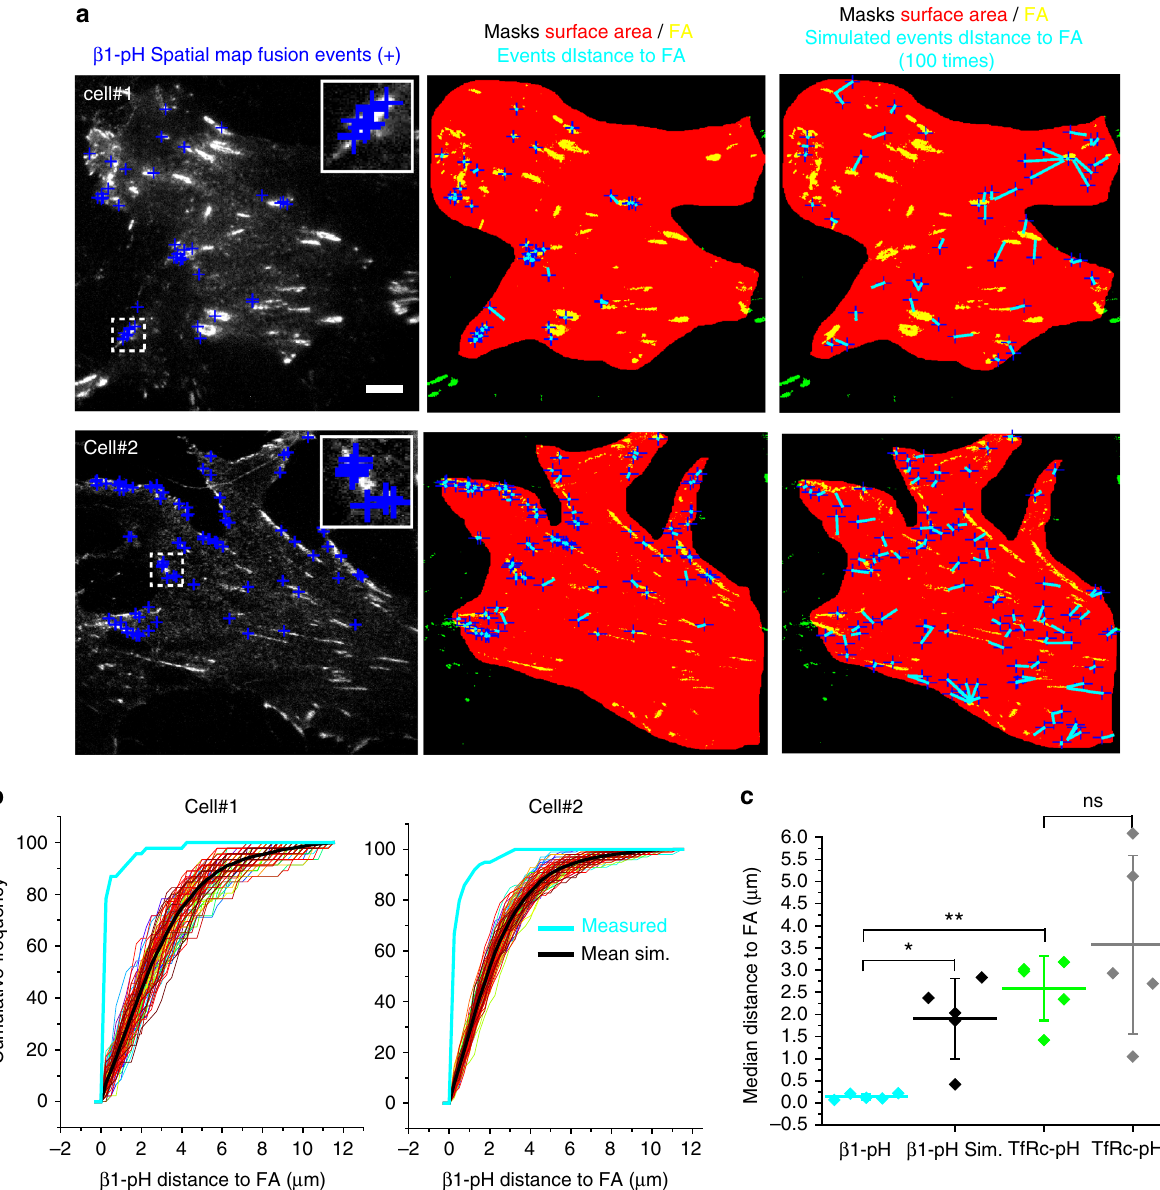
Fig. 6 Spatial distribution analysis of ecto-pH4 β 1 integrin fusion events supports direct integrin delivery to FAs. a Left panel , Distribution of fusion events ( blue crosses ) and FAs ( white ) detected by TIRFM in two KO fi broblasts reconstituted with ecto-pH4 β 1 integrins ( β 1-pH). Center panel , the distance of fusion events to the nearest FA ( yellow mask ) was measured ( cyan lines ). Right panel , the distance of randomly simulated events around the cell surface ( red mask ) to the nearest FA were measured ( cyan lines ). Scale bar , 10 µ m. b Cumulative frequency charts for the two cells demonstrating the difference in distance to FA between the measured data ( cyan line ) and 100 simulations (individual simulation, color lines ; mean, black line ). c Quanti fi cation of the median distance to FAs for β 1-pH or TfRc-pH fusion events, and the simulations ( β 1-pH Sim and TfRc-pH Sim) performed in the same cells. The scatter-box graph shows the mean ± SD for 5 cells and the respective simulation data. Statistical analysis was performed using a two samples Student ’ s t -test. * p < 0.05, ** p < Live imaging of pHluorin- β 1 integrin exocytosis . Having in a burst of green fl uorescence. This burst of fl uorescence is expected to be transient due to the rapid diffusion of the pHluorin established the functionality of ecto-tagged β 1 integrins, we cargo in the plasma membrane. sought to take advantage of the pH sensitivity of pHluorin fl uorescence to visualize integrin exocytosis in live cells. Based on integrin were imaged by TIRFM to visualize pHluorin- β 1 our experience with previously generated ecto-pHluorin-tagged integrin exocytosis at the plasma membrane-matrix interface membrane proteins 42 – 44 , we predicted that (1) ecto-pHluorin β 1 integrins would emit little fl uorescence in secretory vesicles due to (Fig. 5a) 43, 44 . Live-cell TIRFM imaging con fi rmed our the quenching of ecliptic pHluorin at acidic pH, and that (2) observation in fi xed cells that pHluorin- β 1 integrin localized to during exocytosis, ecto-pHluorin β 1 integrin-loaded secretory FAs (Fig. 5a, magenta label ). Similar results were obtained in vesicles fusing with the plasma membrane would expose their HeLa cells stably expressing pHluorin- β 1 integrin on a wild-type β 1 integrin background (Fig. 5b), supporting that our constructs cargo to the neutral extracellular environment (pH~7.4) resulting